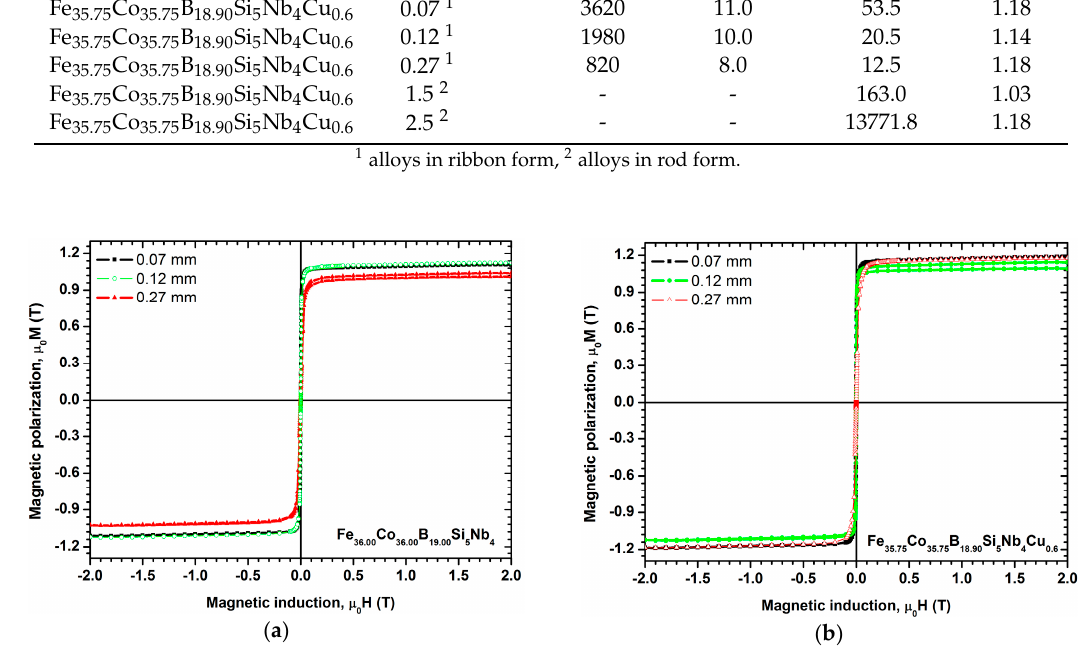
Table 1. The results of magnetic properties ( µ i , ∆ µ / µ , H c , J s ) of the test specimens from the Fe 36.00 Co 36.00 B 19.00 Si 5 Nb 4 and the Fe 35.75 Co 35.75 B 18.90 Si 5 Nb 4 Cu 0.6 alloys in the form of ribbons and rods. Figure 12. SEM micrographs of the fracture morphology of the Fe 35.75 Co 35.75 B 18.90 Si 5 Nb 4 Cu 0.6 rod with the diameter of 1.5 mm; ( a ) main view; ( b ) image of fragment I marked in (a) at higher magnification; ( c ) image of fragment II marked in (a) at higher magnification; ( d ) EDS spectrum from area in (c); ( e ) image of fragment III marked in (a) at higher magnification; ( f ) EDS spectrum from area in (e).